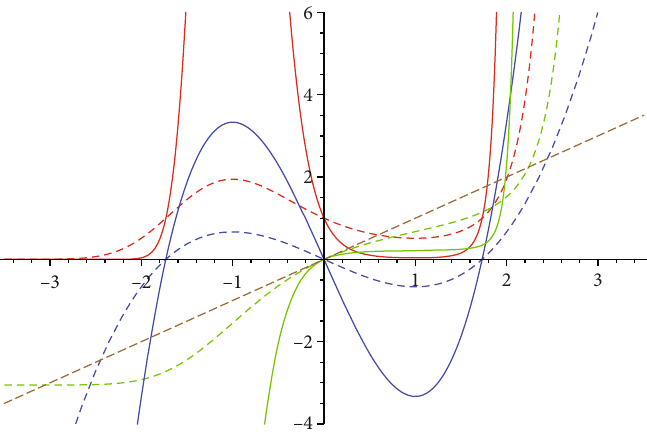
Ð x e μ ðð 1/3 Þ s 3 − s Þ ds (green), μ = 1 (dashed), and μ = 5 (solid). 0